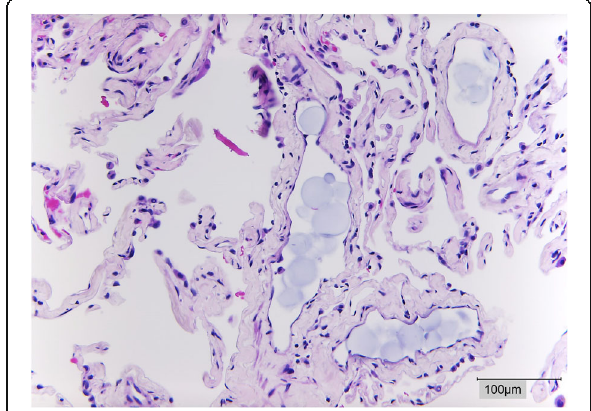
Fig. 8 Histological section of sedimented DSM a t90 with biggest aggregates of 150 μ m, sample was graded as 3 according to the semiquantitative ordinal